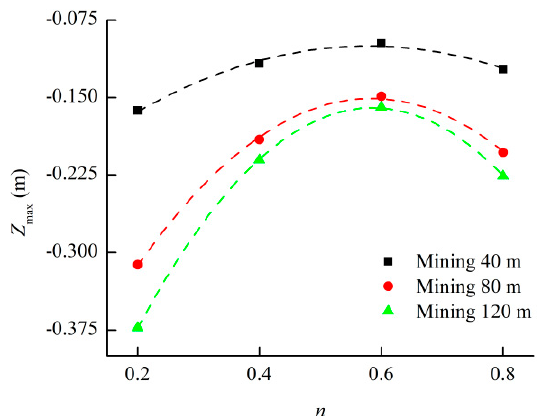
Figure 13. Relationship between the maximum subsidence displacement of the coal seam roof and the Talbot index of the cemented rockfill at different mining distances.